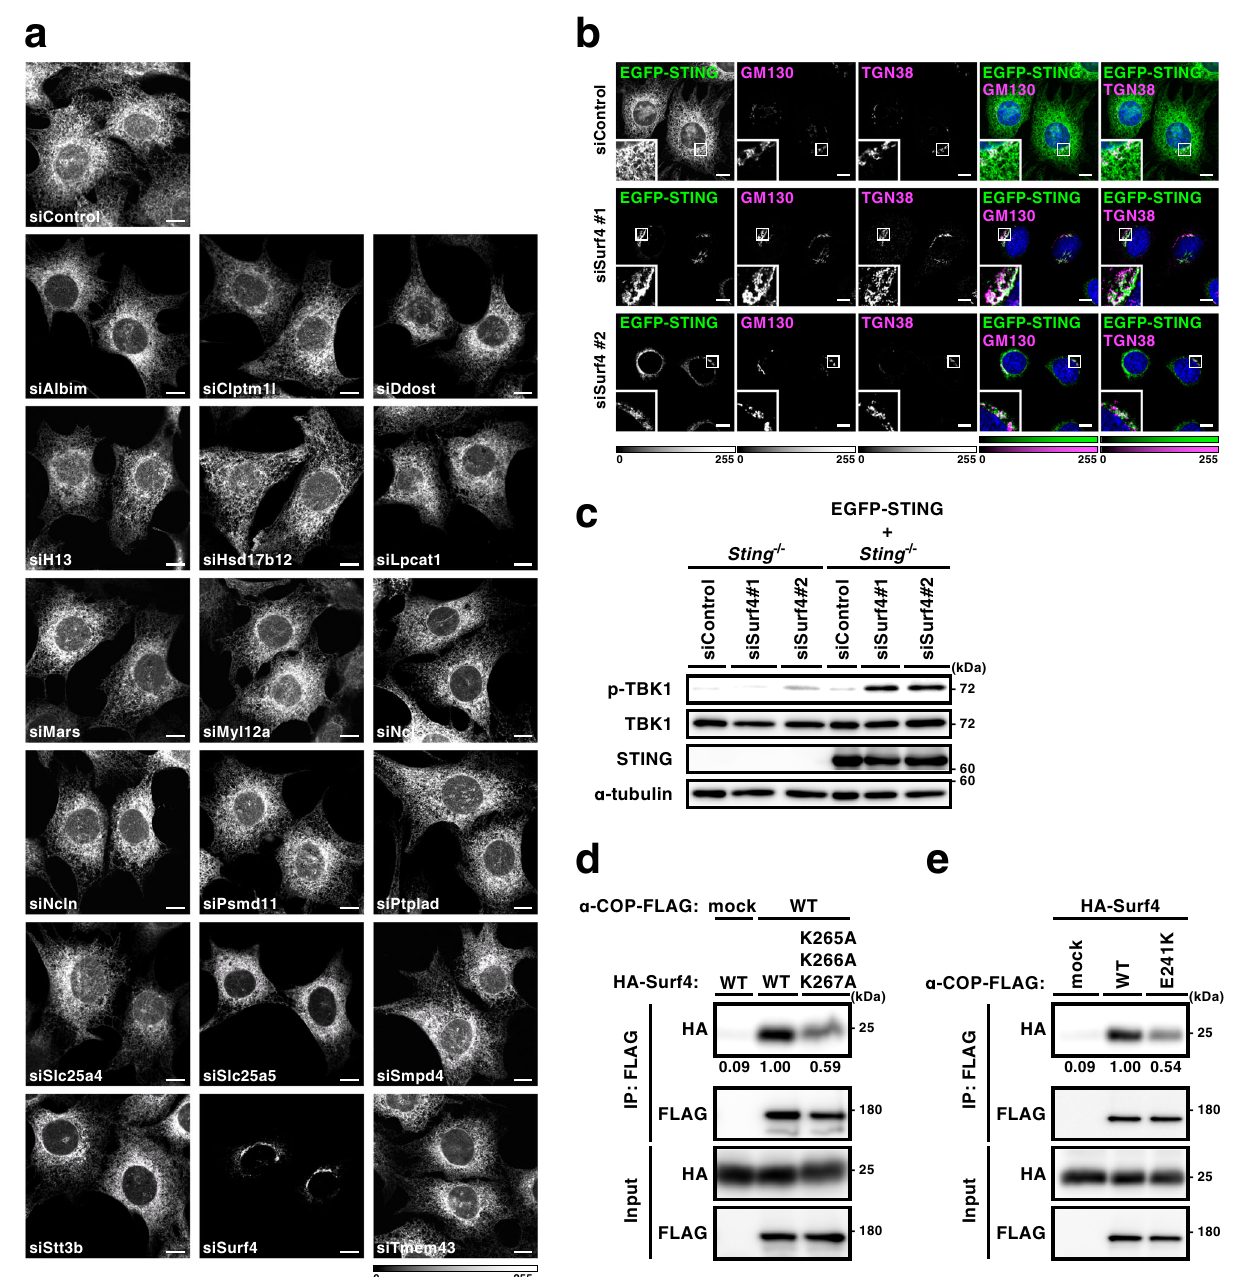
Fig. 3 Surf4 binds STING and α -COP, and is required for STING localization to the ER. a , b MEFs expressing EGFP-STING were treated with the indicated siRNA for 48 h. Cells were fi xed, permeabilized, and stained for GM130 and TGN38. Color scales and intensity levels are indicated below images. Scale bars, 10 µ m. c Sting − / − MEFs or Sting − / − MEFs reconstituted of EGFP-STING were treated with the indicated siRNA. Cell lysates were prepared and analyzed by western blot. d , e HEK293T cells were transfected with the indicated plasmids. Cell lysates were prepared and α -COP-FLAG was immunoprecipitated. Cell lysates and the immunoprecipitates were analyzed by western (Supplementary Fig. 16b), and (iii) STING translocated to The translocation of STING from the ER to the Golgi in cGAS- perinuclear compartments that include the Golgi (Supplementary Fig. 16c). We depleted Surf4 by siRNA in cGAS-knockout cells and found that STING still translocated to the Golgi (Supple- mentary Fig. 13a) and that TBK1 was phosphorylated (Supple- mentary Fig. 13b). These results suggested that the translocation of STING from the ER to the Golgi does not necessarily require cGAMP and that the forced Golgi residency of STING with the impaired retrograde transport would suf fi ce to activate the STING signaling pathway in the absence of cGAMP.